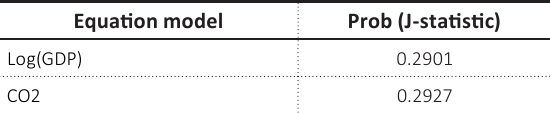
Table 10. Sargan test results